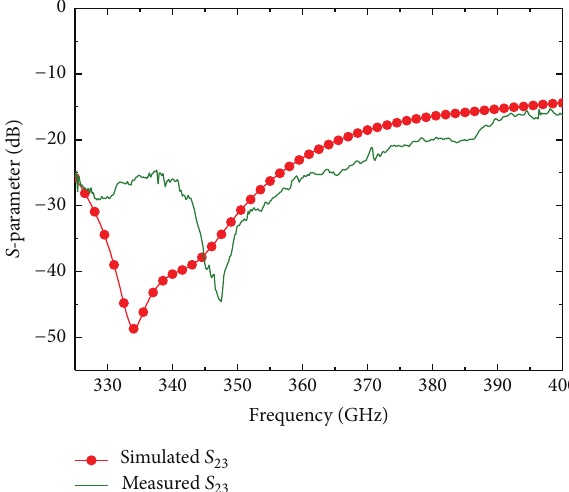
Figure 13: Measured 𝑆 -parameter compared with measured and simulated results of the through coupling topology.